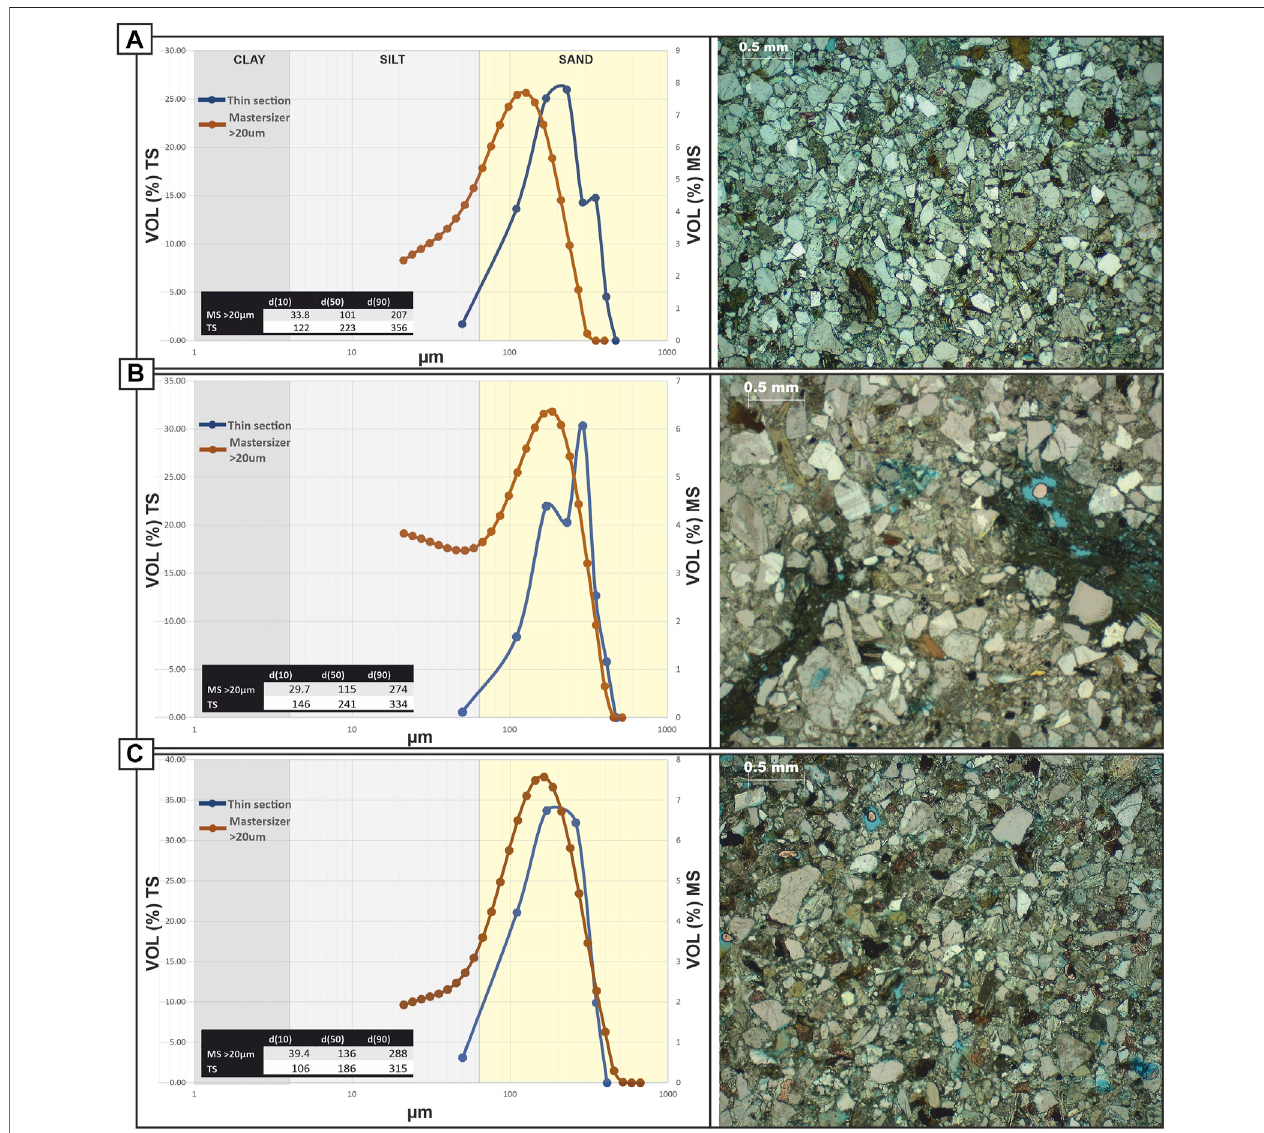
FIGURE12| VolumefrequencygraphsfromMastersizerdatacompared tovolumefrequencygraphsplottedfromthinsectionmeasurement.Thegrain-sizeatthe 10th, 50th and 90th percentile for the Mastersizer curve (MS) and from thin-section (TS) are shown in the inset graph. Data less than 20 µm were removed from the Mastersizer for more accurate comparison with thin section. Representative photos are shown for each thin section. (A) Example from the Marnoso-Arenacea Formation, location Coniale 1 ( Figure 1B ),bed 2, sample 1, collected from a sand-rich turbidite (Amy and Talling, 2006). (B) Example from the Marnoso-Arenacea Formation, location Coniale 2 ( Figure 1 ), bed 1, sample 5B, collected from a clast within a hybrid event bed (Amy and Talling, 2006). (C) Example from the Castagnola Formation from log IV, bed 210 ( Figure 1B ), sample 5, collected from the sand-rich base of a hybrid event bed (Southern et al., 2015).